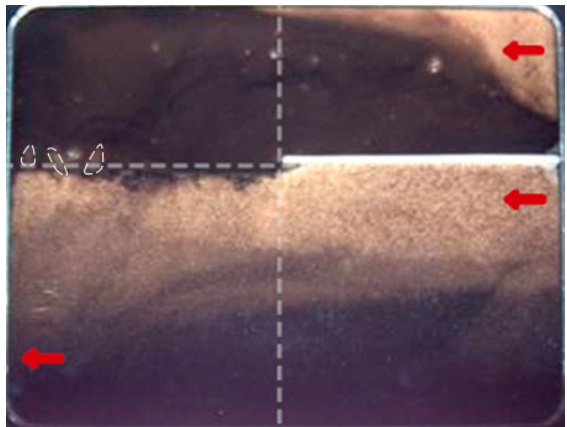
Figure 9. Development diagram of fingering phenomenon at the bottom of low-permeability layer. (The arrow at the right side is the injection end; the arrow at the left side is the production end). Table 1. Data table of the proportion of gas absorption range of high and low permeability layers in total reservoir space at different production time.